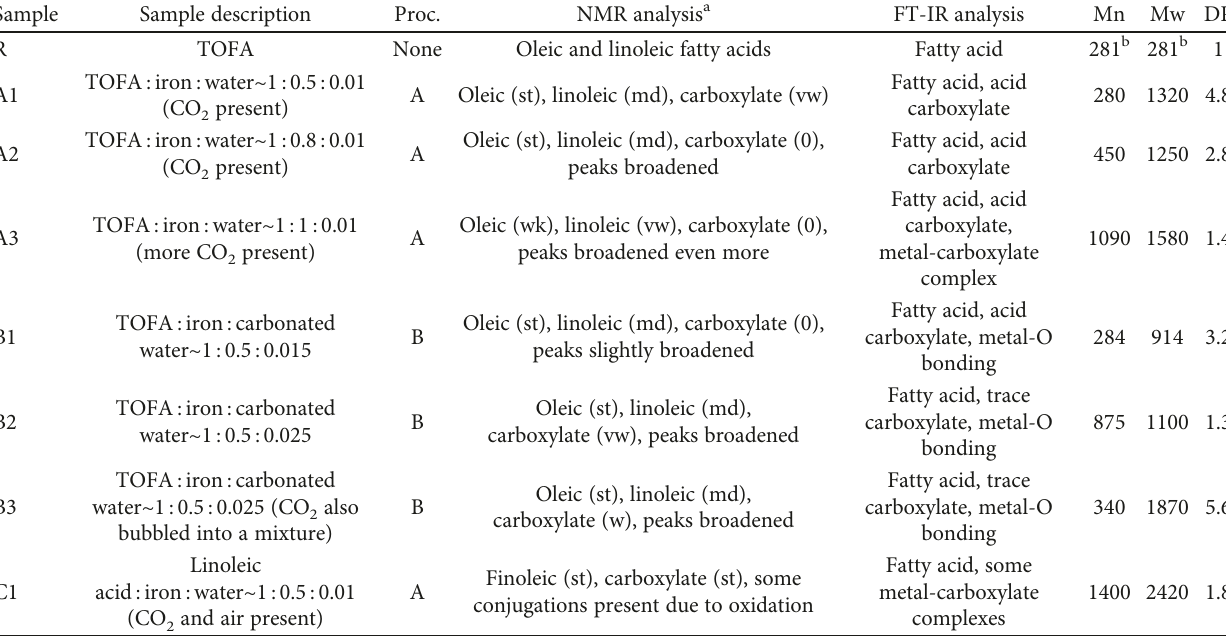
Table 1: NMR, FT-IR, and SEC analyses of the products obtained from a fatty acid/iron/carbon dioxide/water reaction using procedure A or B.